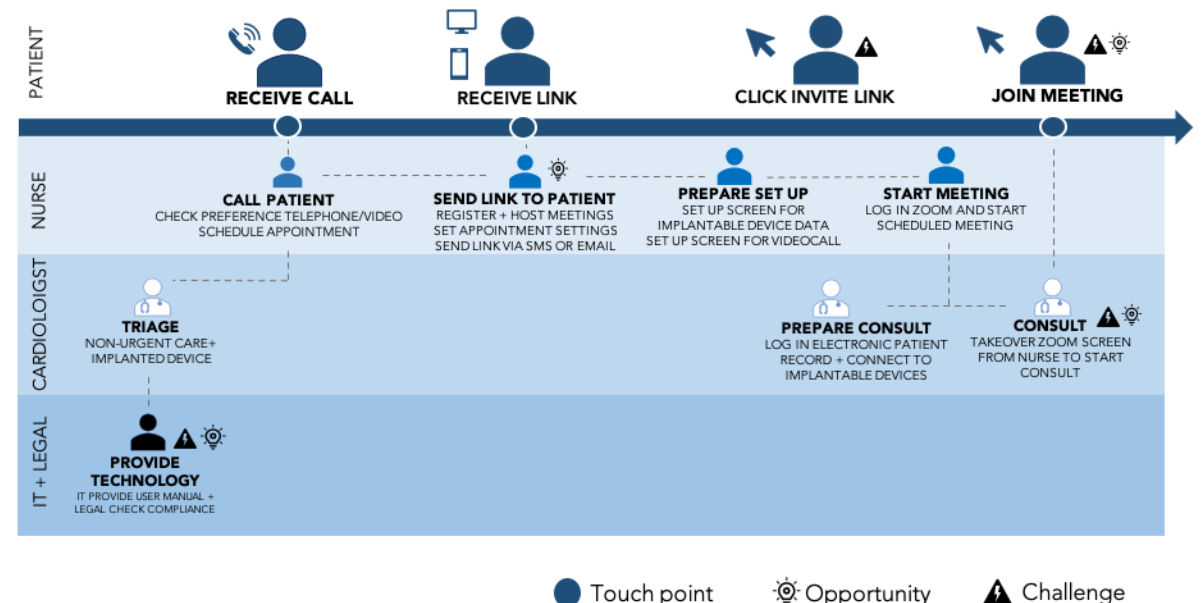
Figure 1. Customer journey of a video consultation for a patient with an implanted device. IT: information technology. SMS: short message service.